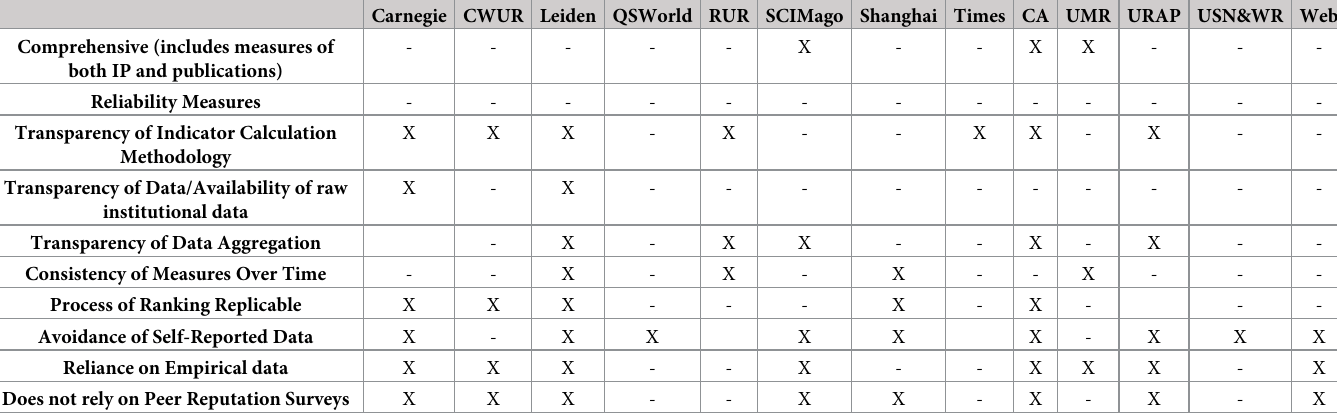
Table 7. Suitability of ranking for research performance